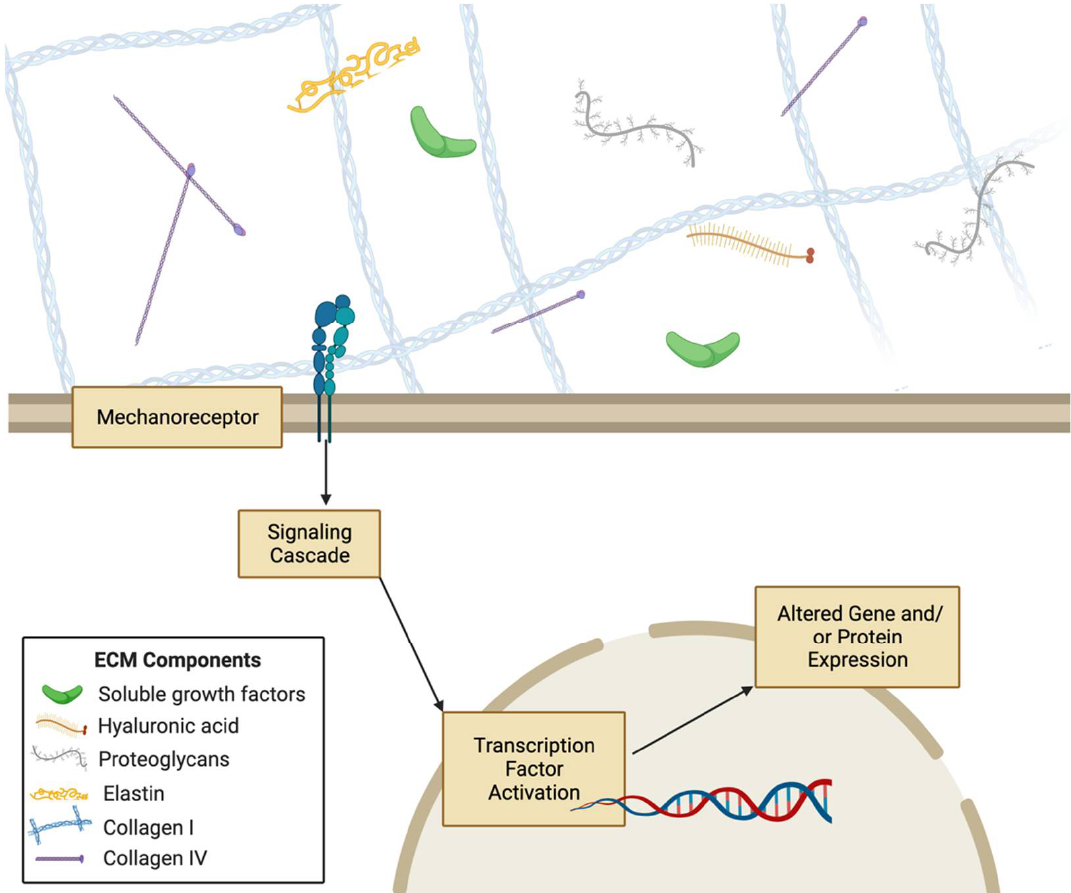
Figure 1. Extracellular matrix (ECM) and cellular mechanotransduction. ECM components such as collagens can alter mechanical properties to induce changes in cellular signaling and gene or protein expression via mechanoreceptors and mechanotransduction proteins. Legend on the bottom left shows which ECM component is represented by each symbol. (Created with BioRender.com, accessed on 29 May 2022) .